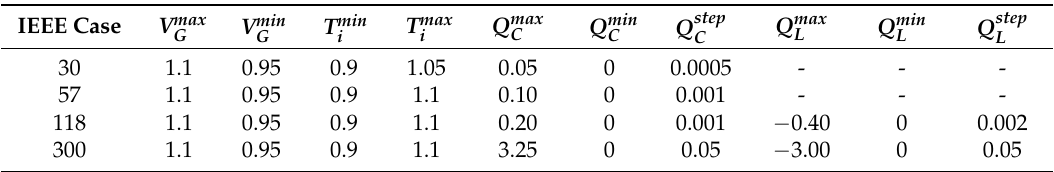
Table 4. Limits of control variables for different IEEE cases